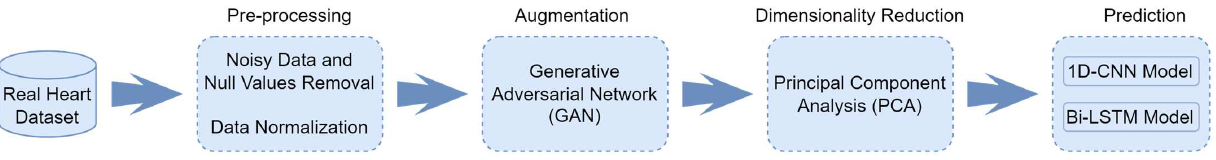
Figure 1. Basic process of GAN-1D-CNN and GAN-Bi-LSTM frameworks.